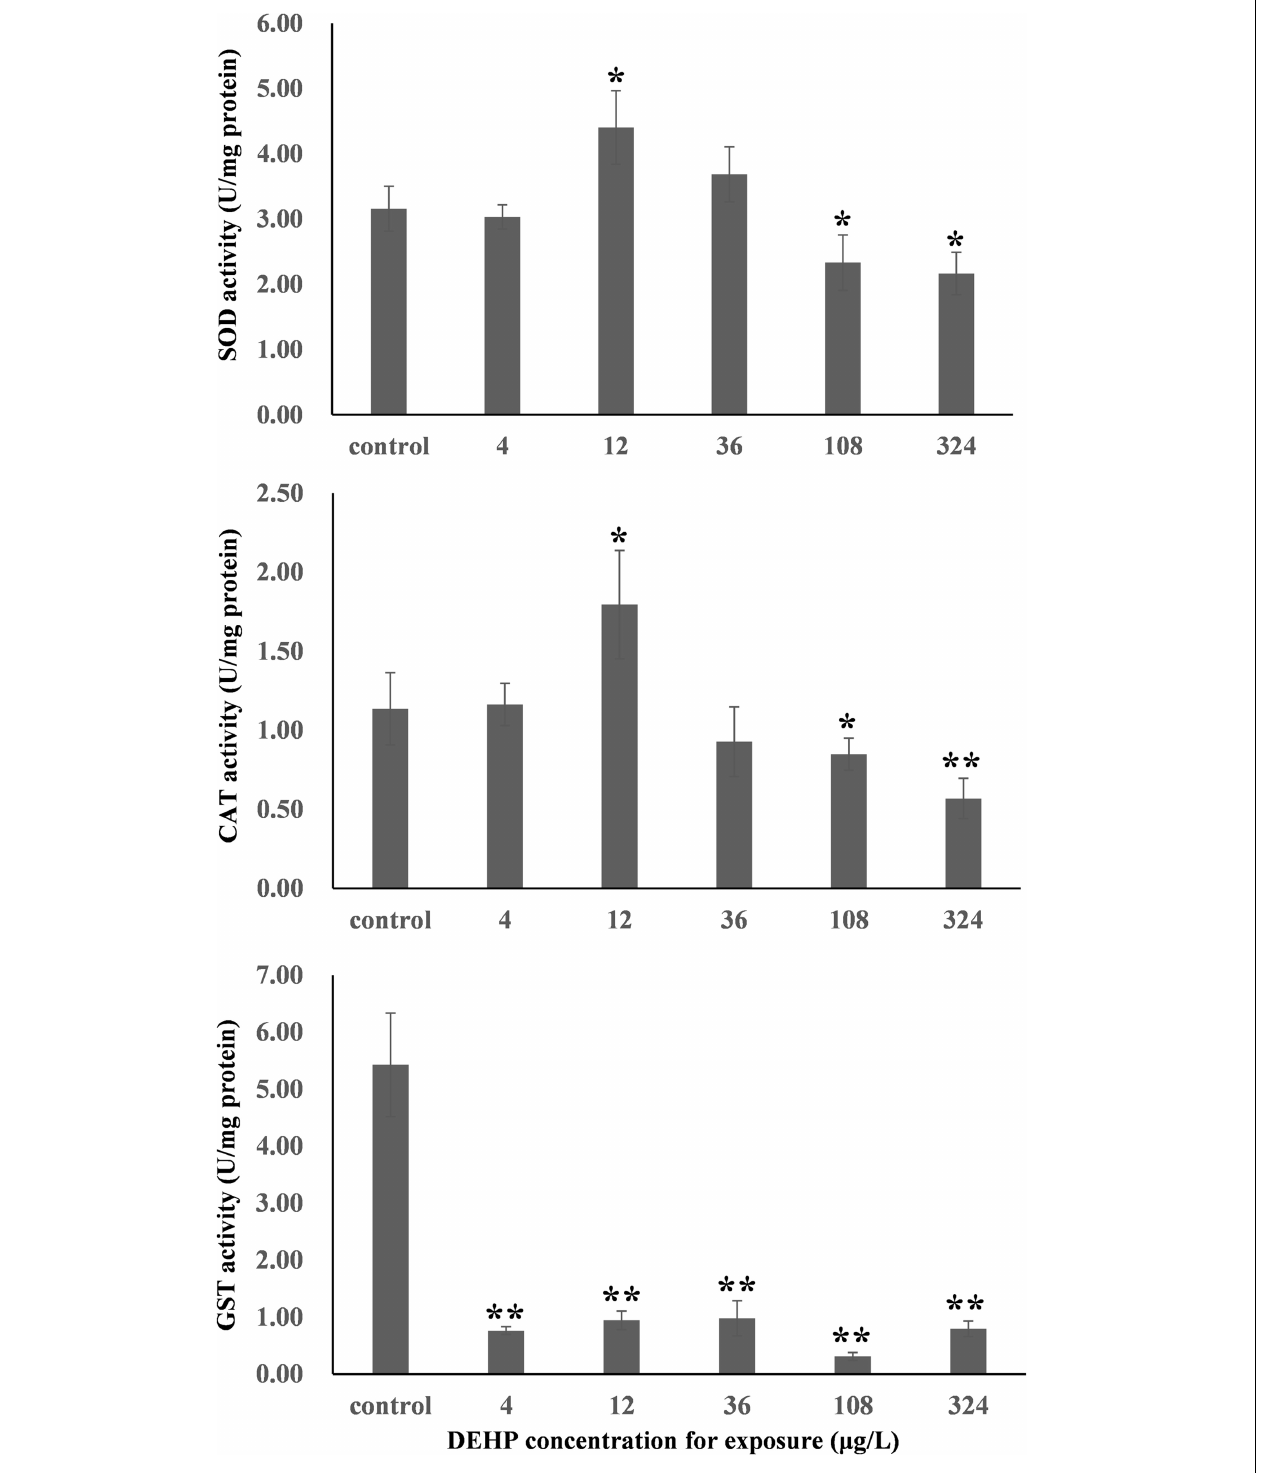
FIGURE 2 | One-way ANOVA was used to analyze the differences of SOD, CAT, and GST activities (U/mg protein) between the DEHP exposed group and the control group. ∗ P < 0.05. ∗∗ P < 0.01. CAT, catalase; GST, glutathione S-transferase; SOD, superoxide dismutase.